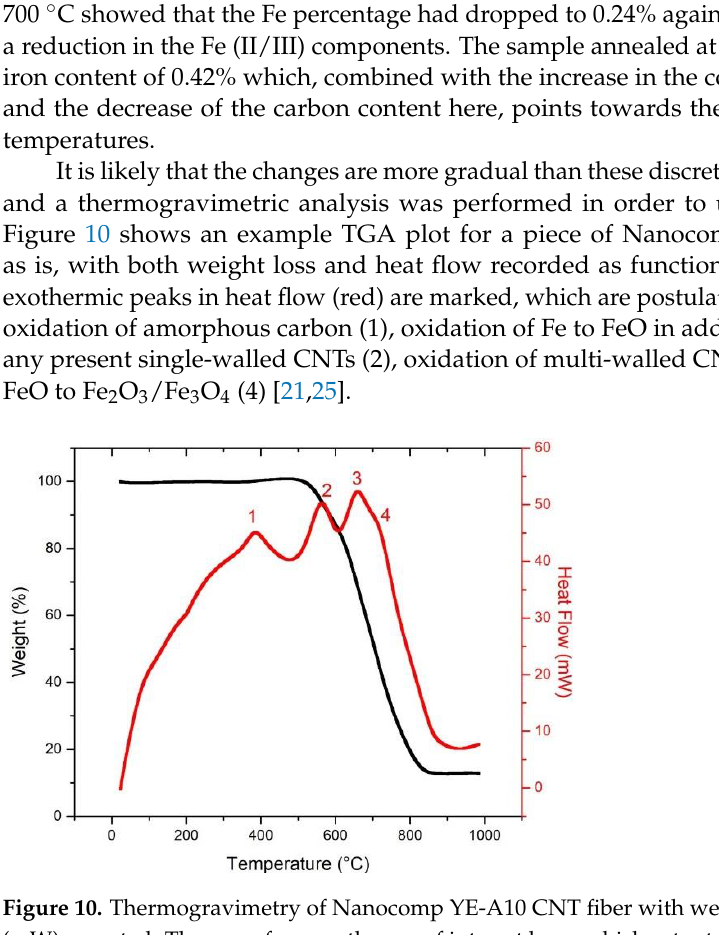
Figure 9. O 1s peak fits for the CNT fibers annealed at ( a ) 100 °C and ( b ) 500 °C showing the relative composition of oxygen content in the fibers varies, indicative of more metal oxide at the higher annealing temperature.